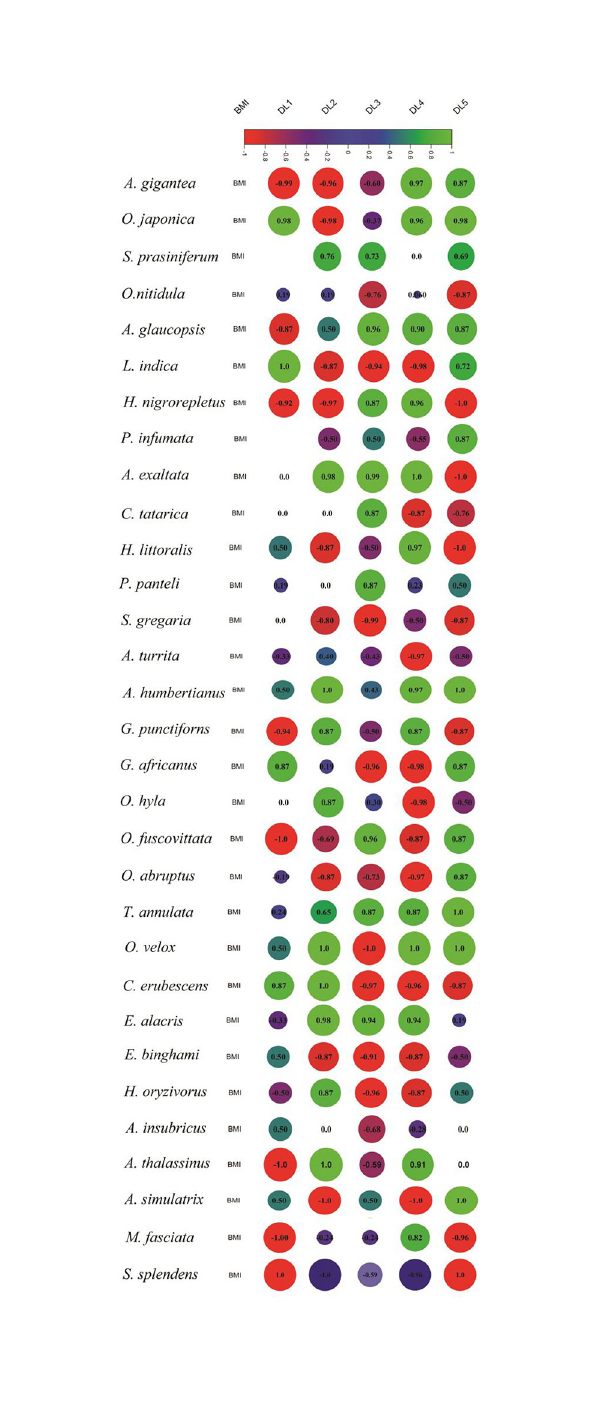
PLOS ONE | https://doi.org/10.1371/journal.pone.0265664 June 3,